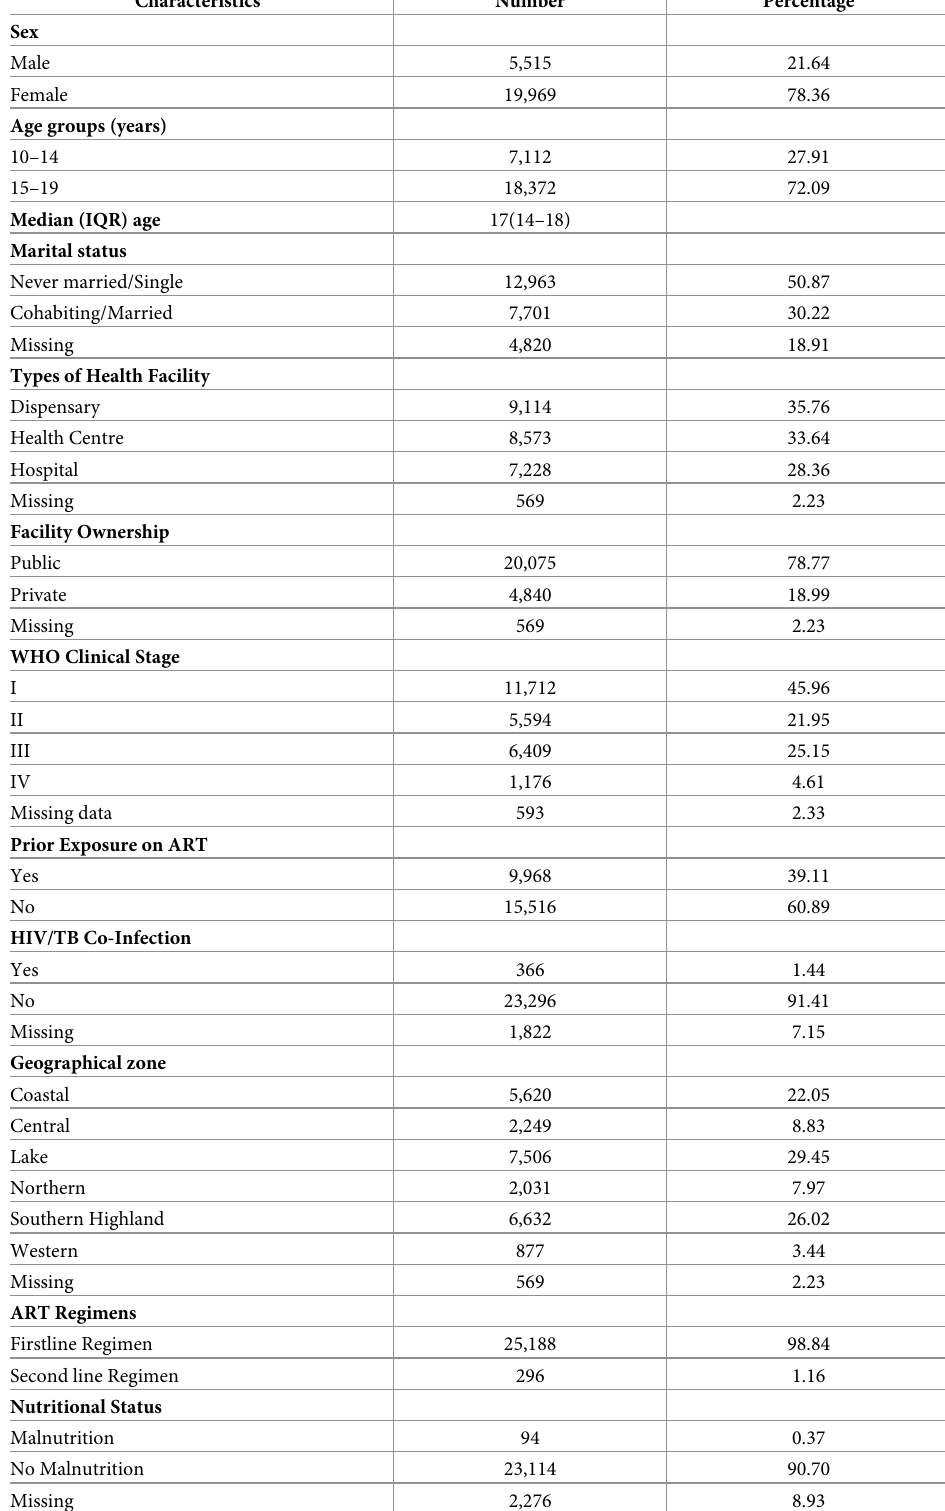
Table 1. Characteristics of adolescents on ART (N =